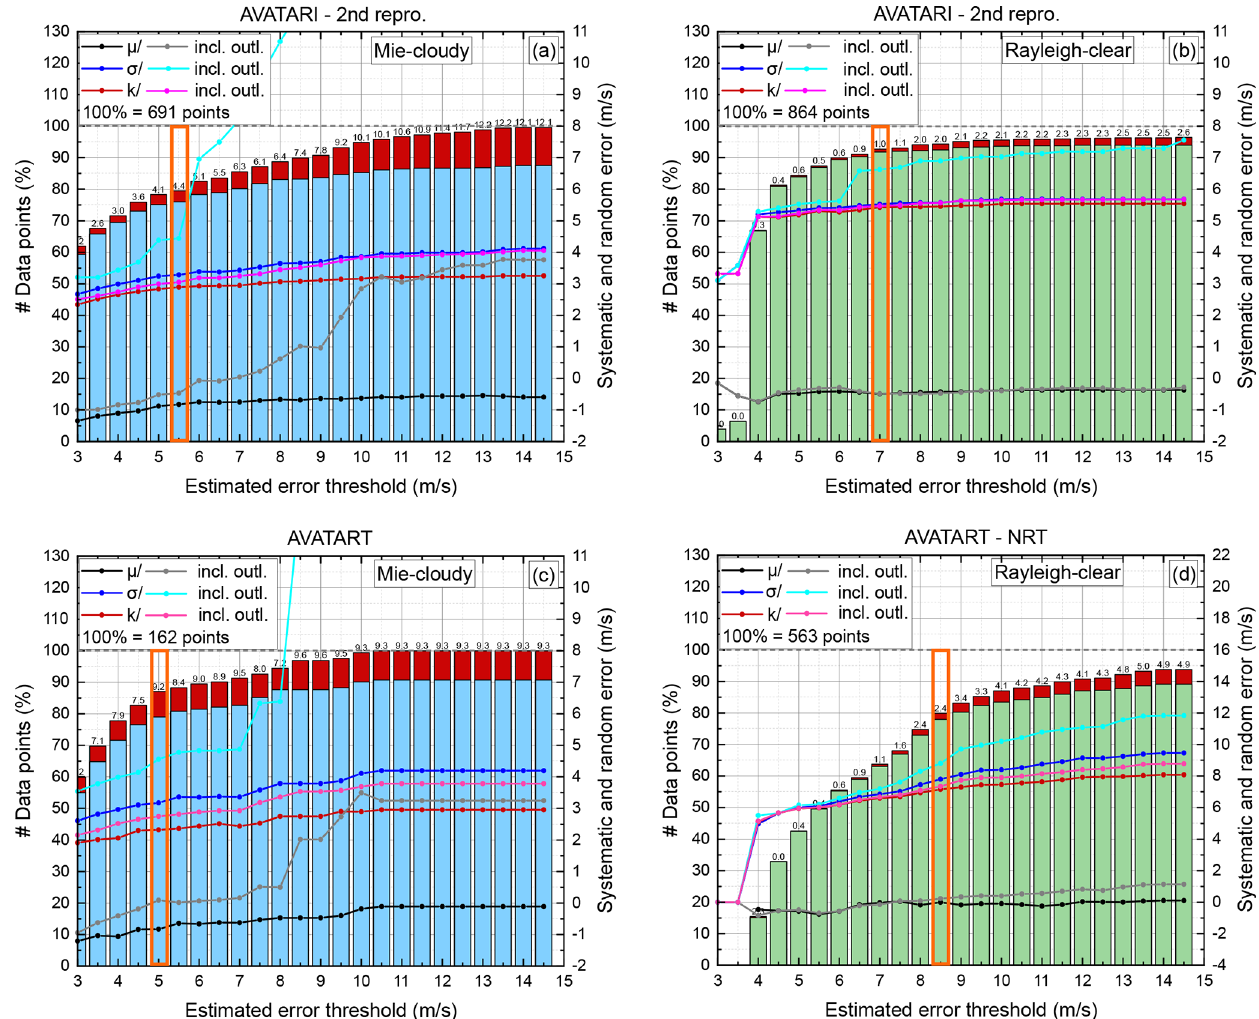
Figure 4. Results from the statistical comparison of Aeolus L2B Mie-cloudy (a, c) and Rayleigh-clear winds (b, d) against 2µmDWL data (one scan accumulation) are shown from the 10 underflights of the AVATAR-I campaign (a, b) and the 11 underflights of the AVATAR-T campaign (c, d) , depending on the EE threshold without and with outlier removal based on the modified Z score. The bar plots depict the portion of filtered winds after QC ( Z m < 3, green and blue bars) and gross errors ( Z m > 3, red bars) from all wind results that are flagged as valid in the L2B product (left y axes). The percentage of gross errors is indicated above the bars. The lines and symbols refer to the statistical results (mean bias µ , standard deviation σ , and scaled MAD k ) without removing the gross errors from the data sets (gray, light blue, magenta), while the black, blue, and red lines represent the statistical parameters after QC based on the modified Z score (right y axes). The EE thresholds that are deemed reasonable to provide robust statistical results are highlighted by orange